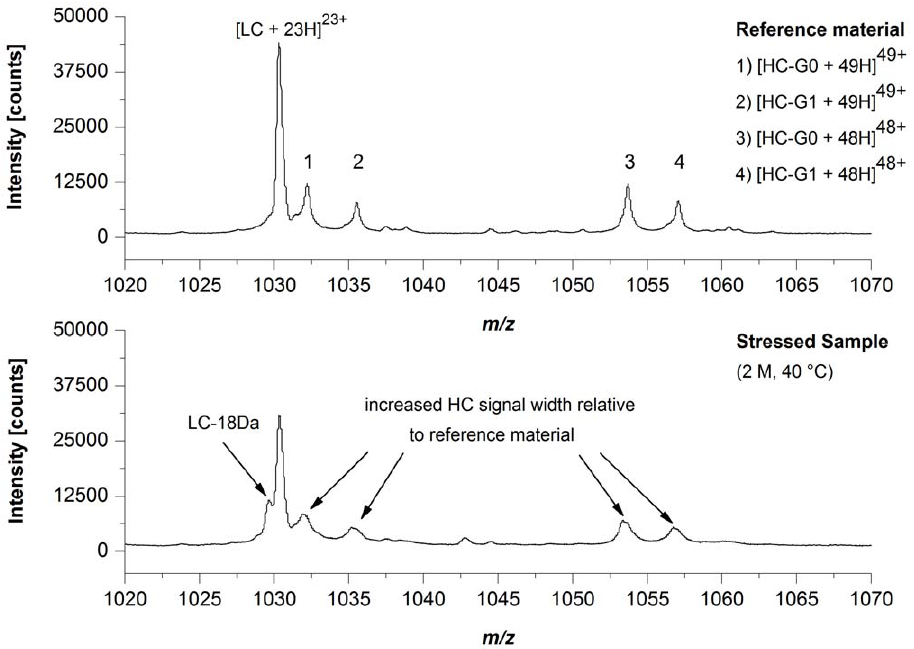
Figure 5. ESI-QTOF mass spectrometry of reduced Mab1. NanoESI-QTOF mass spectra of Mab1 reference material and Mab1 stressed sample (stored at 40 u C for 2 month). The spectra were recorded in the positive ion mode using acetonitrile/water/formic acid (79/20/1, v/v/v) as solvent. LC, light chain; HC-G0, non-galactosylated heavy chain; HC-G1, mono-galactosylated heavy chain.